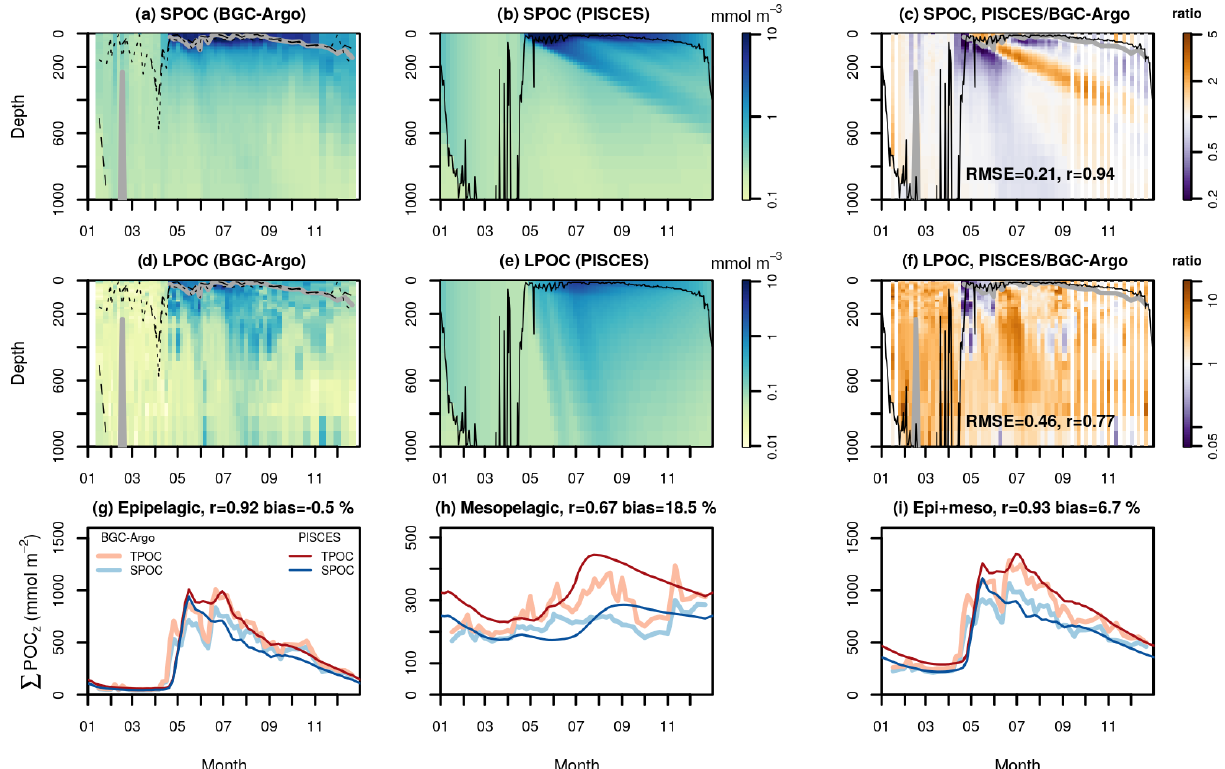
Figure 6. Temporal evolution of small and large POC concentrations (SPOC and LPOC, respectively) in the North Atlantic subpolar gyre (NASPG). Panels (a) and (d) show observations from the BGC-Argo float WMO 6901486, which drifted in the Labrador Sea during the year 2015. Panels (b) and (e) show the corresponding PISCES 1D simulation. Panels (c) and (f) show the ratio between the model and the observations and the corresponding correlation coefficient and RMSE in log 10 scale. Solid lines depict the observed MLD ( a and d , in gray) and the simulated turbocline depth ( b and e , in black). In panels a and d , the dotted lines show the depths of the maximum Chl a fluorescence gradient and the dashed lines an alternative MLD estimated with a 0.005 ◦ C temperature threshold that captures weak stratification. Panels (g) , (h) , and (i) show the vertically integrated SPOC and LPOC stocks in different layers: 0–200m or epipelagic (g) , 200–1000m or mesopelagic (g) , and 0–1000m (i) . On top of panels (g) – (i) we show the correlation and mean bias between BGC-Argo and PISCES total POC